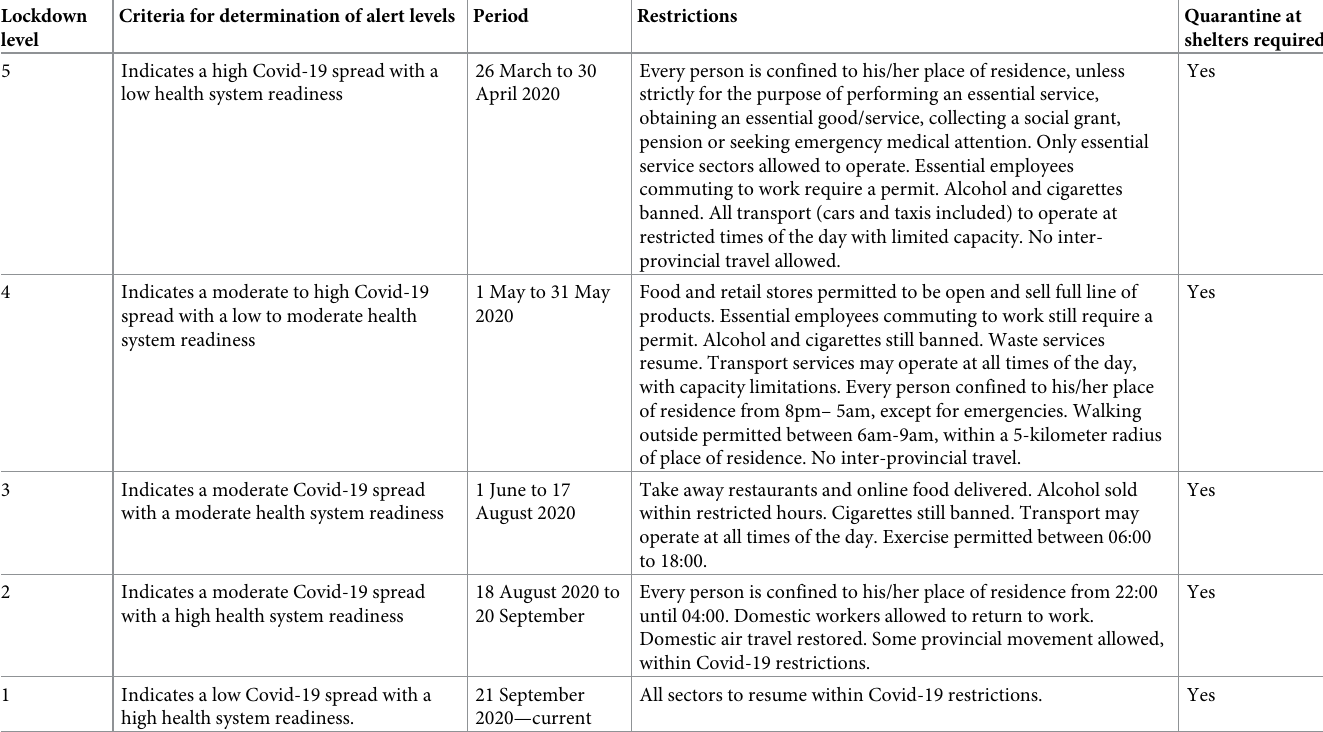
Table 1. South Africa’s COVID-19 lockdown levels, period and summary of